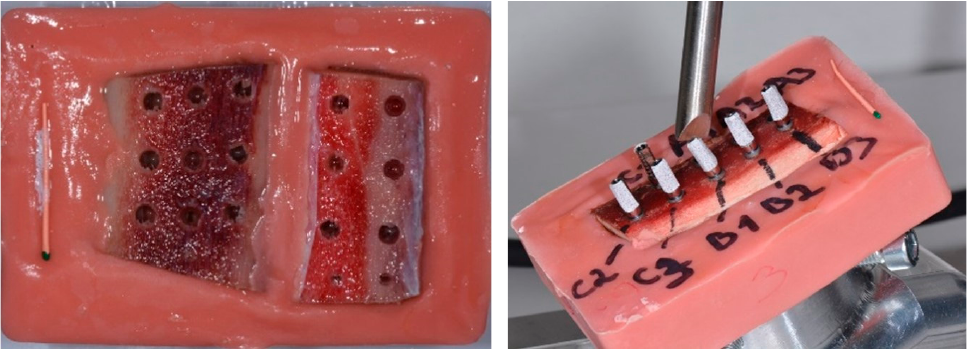
Figure 4. Fresh bovine bone (class 2) and loading process for each dental implant systems.